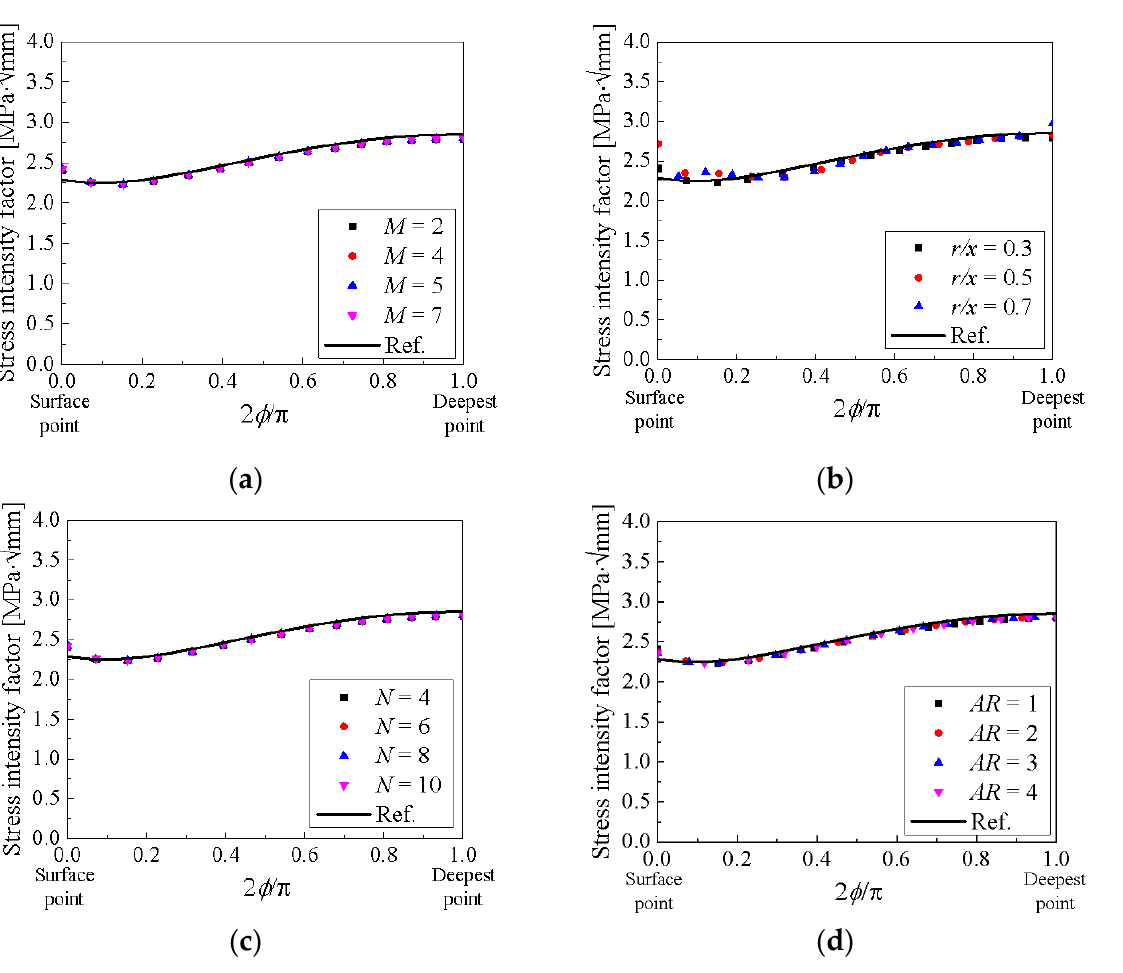
Figure 7. Comparison of SIFs according to crack tip mesh shape variables: ( a ) The number of elements in the radial direction of the contour ( M ); ( b ) The ratio of the relative contour size to the crack size ( r/x ); ( c ) The number of elements in the circumferential direction inside the contour ( N ); ( d ) The ratio of the total length of the crack tip to the radial size of the element ( AR )